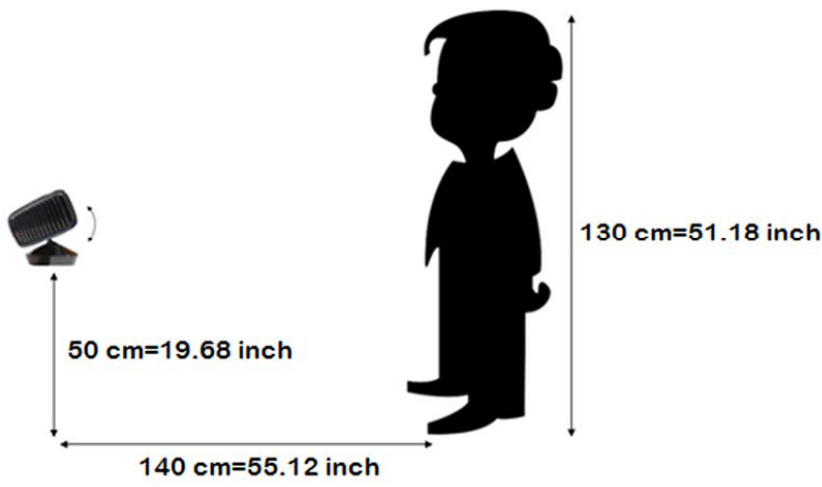
Figure 2. SONRIE game environment configuration.